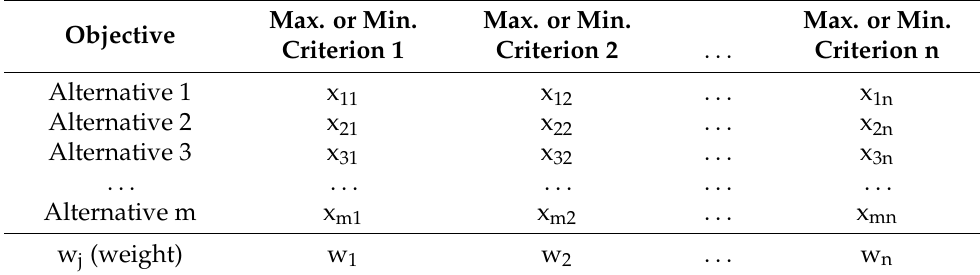
Table 9. Matrix of decision example for TOPSIS